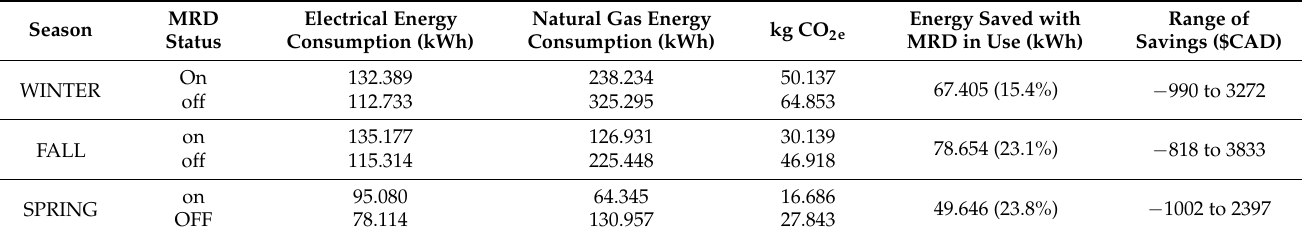
Table 7. Summary of MRD results.